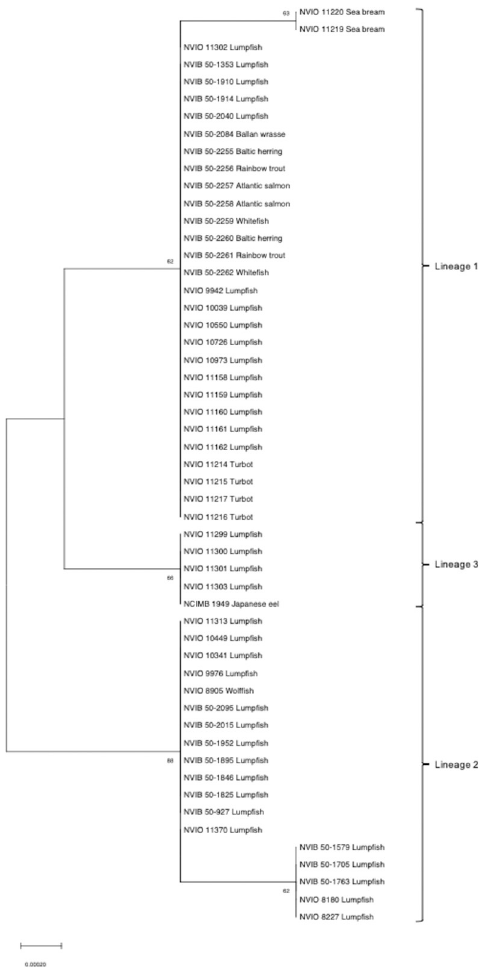
Fig 2. Phylogenetic reconstruction of 53 isolates of P . anguilliseptica based on concatenated aroE , recA , rpoB , ileS , rpoD , glnS , atpD , gyrB and carA amino acid sequences. Bootstrap support values are shown next to the branches. The length of the scale bar corresponds to 0.00020 substitutions per site. Brackets refer to the major lineages formed following the phylogenetic reconstruction. Annotation: Norwegian Veterinary Institute Bergen/Oslo (NVIB/NVIO), isolate number, fish species.